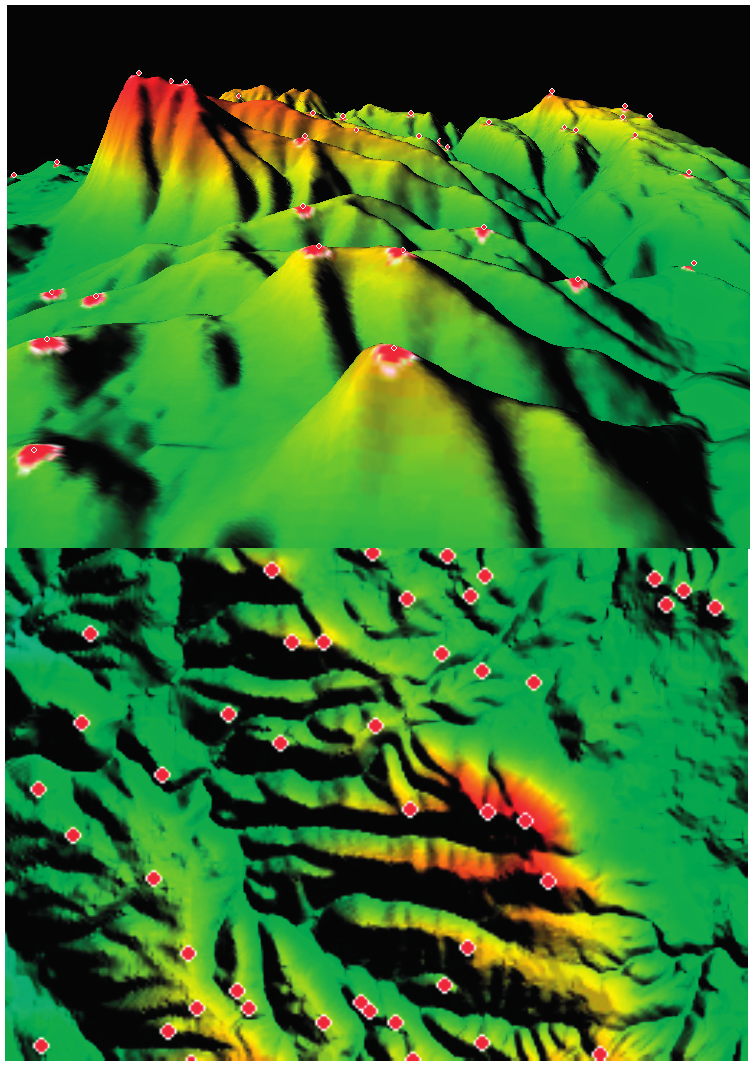
Figure 9. 3D ( up ) and 2D ( bottom ) visualization of interest point identification superimposed on the